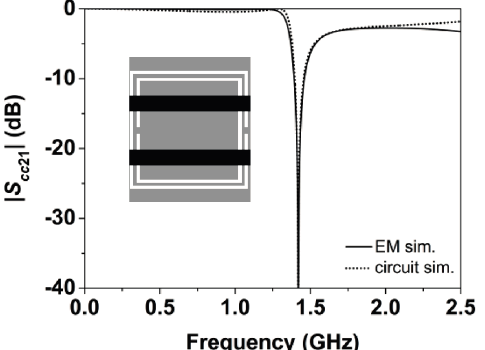
Figure 7. Simulated common-mode insertion loss | S cc 21 | for the structure shown in the inset. CSRR dimensions are: c = 0.2 mm, d = 0.2 mm, W = 1 mm, S = 2.5 mm, and side length of 7.6 mm. The considered substrate is Rogers RO3010 with thickness h = 1.27 mm and dielectric constant ε r = 10.2. Extracted parameters are L e = 9.86 nH, C = 1.06 pF, C c = 2.68 pF and L c = 3.36 nH. From [36]; reprinted with permission from IEEE 2011.